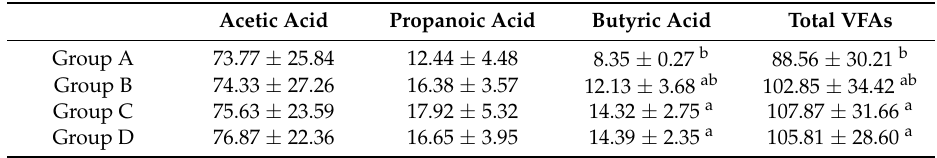
Table 7. Effect of intragastric administration with C. butyricum Sx-01, L. salivarius C-1-3 and a combination thereof on blood excrement VFAs concentration of mice (Day 14).